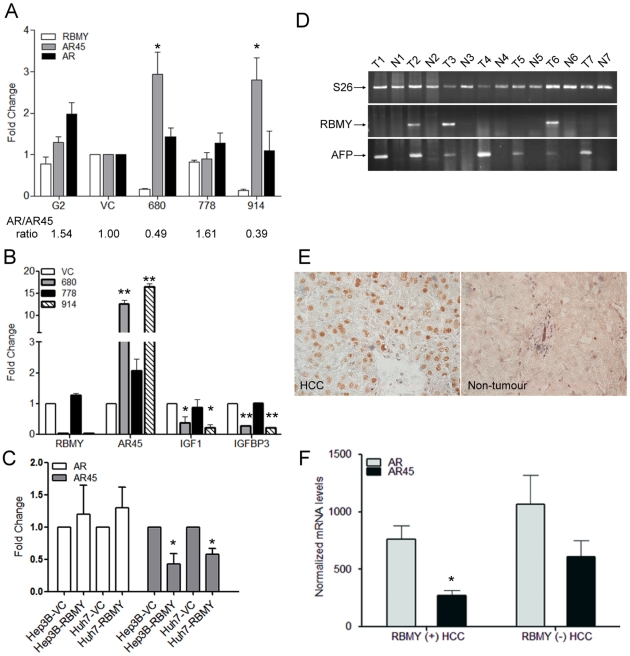
RBMY expression correlated with reduced androgen receptor AR45 variant in human hepatoma cell lines and male HCC tissues.(A) Semi-quantitative RT-PCR and densitometric analysis of RBMY, AR and AR45 in parental (G2), vector plasmid (VC), pSUPER-680, pSUPER-778, and pSUPER-914 plasmids transfected HepG2 cells. (B) Quantitative RT-PCR analysis of RBMY, AR45, IGF-1 and IGFBP-3 in RBMY knockdown transfectants (680 and 914) and non-knockdown transfectants (VC and 778). Values were normalized against the internal control S26. Data are mean±SD folds over vector control (VC). (C) Quantitative RT-PCR analysis of AR and AR45 in vector control or RBMY transfected Hep3B and Huh7 cells. Data are mean±SD folds over vector control (VC). (D) Semi-quantitative RT-PCR analysis of RBMY in the tumor (T) and non-tumor (N) parts of human male HCCs. S26 is an internal control and alpha fetoprotein (AFP) as a tumor marker. (E) Immuno-histochemical staining of nuclear RBMY protein in HCC tissues only (×400). (F) AR and AR45 mRNA expression in 7 RBMY-expressing and 5 non-expressing human male HCC tissues. The results were the mean of three different experiments. *p<0.05; **p<0.01.